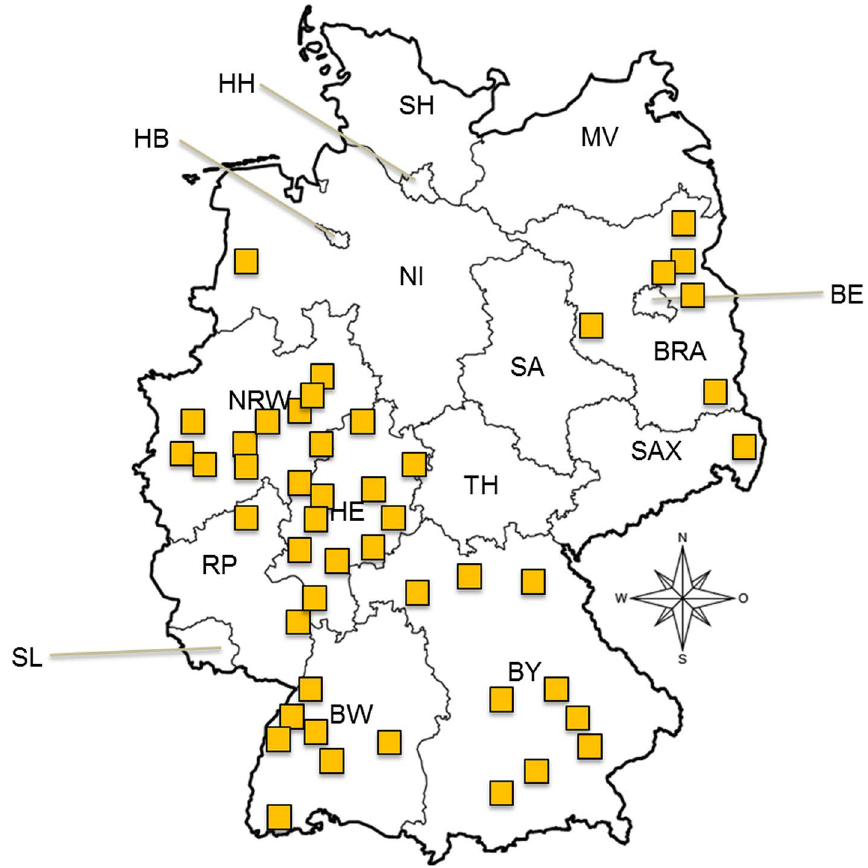
Figure 2. Representative for various hospitals in different Federal states in Germany by CLINOTEL. The highlighted points are representative for various hospitals in different Federal states in Germany by CLINOTEL [33]. Due not to declare which hospital may be less cost effective, the names of the hospitals were anonymized. BW: Baden-Wurttemberg; BY: Bavaria; BE: Berlin; BRA: Brandenburg; HB: Bremen; HH: Hamburg; HE: Hessen; MV: Mecklenburg-Vorpommern; NI: Lower Saxony; NRW: North Rhine- Westphalia; RP: Rheinland-Pfalz; SL: Saarland; SAX: Saxony; SA: Saxony-Anhalt; SH: Schleswig-Holstein; TH: